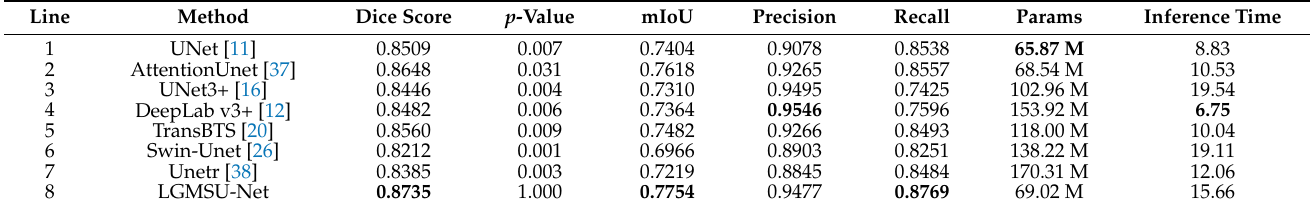
Table 4. Comparison of the proposed LGMSU-Net with seven state-of-the-art methods. All p -Values in this table were obtained by comparing with LGMSU-Net (line 8). The best performance was shown in bold.